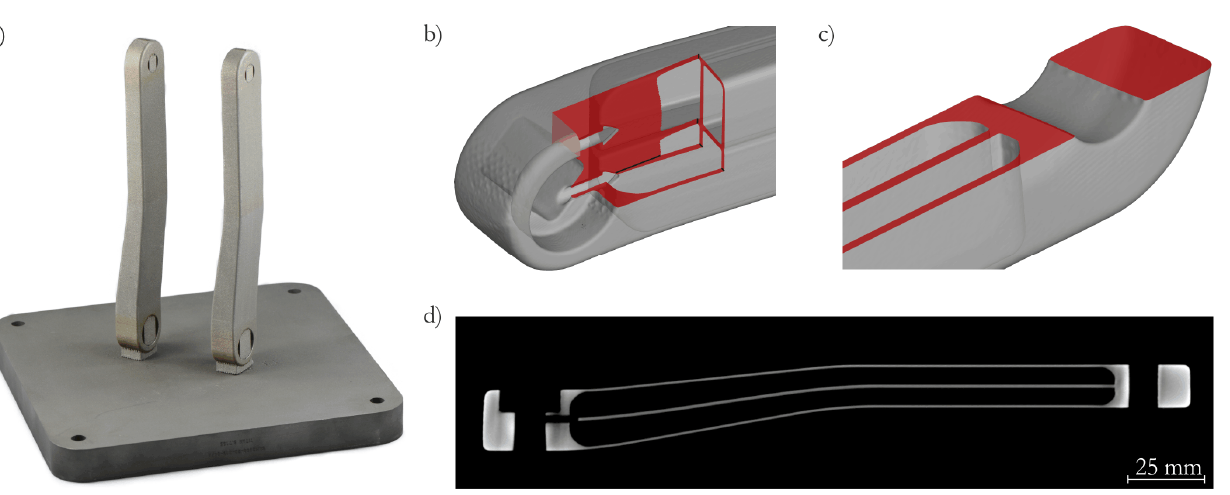
Figure 10: Final product positioned on the substrate platform a) and the nondestructive test results from the computer tomography b), c) and